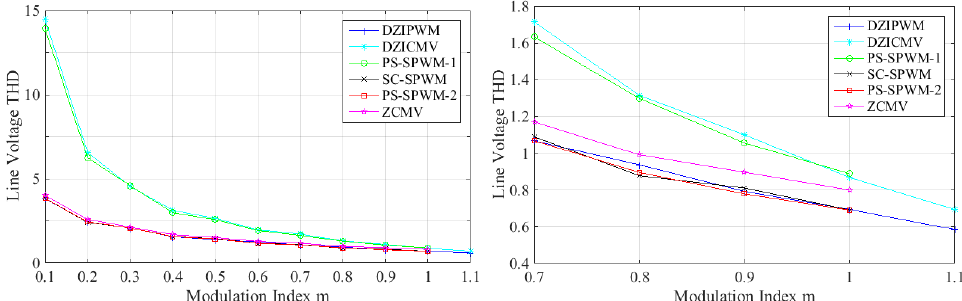
Figure 28. Experimental electromagnetic torque T e and rotor speed n ( left ) DZIPWM; ( right )